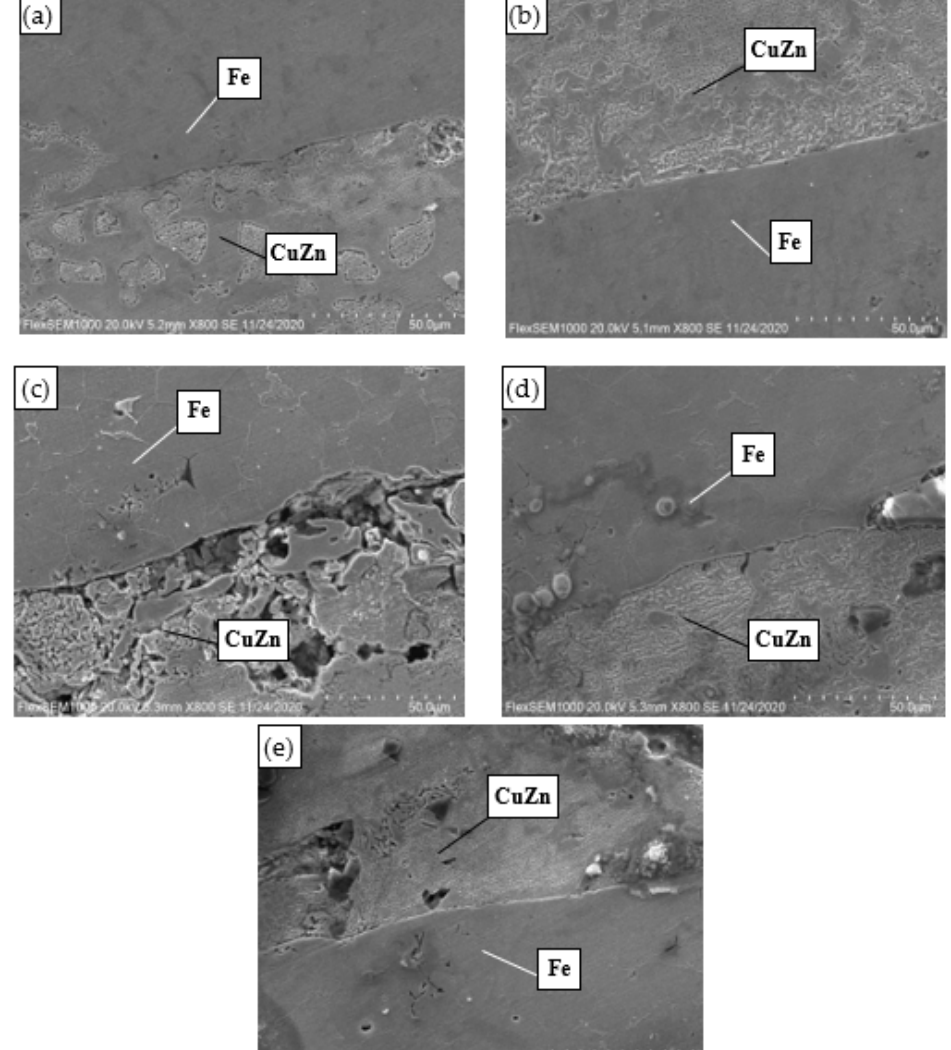
Figure 5. Bonding interface between copper matrix and iron interlayer: ( a ) 740 °C; ( b ) 750 °C; ( c ) 760 °C; ( d ) 770 °C; ( e ) 780 °C.